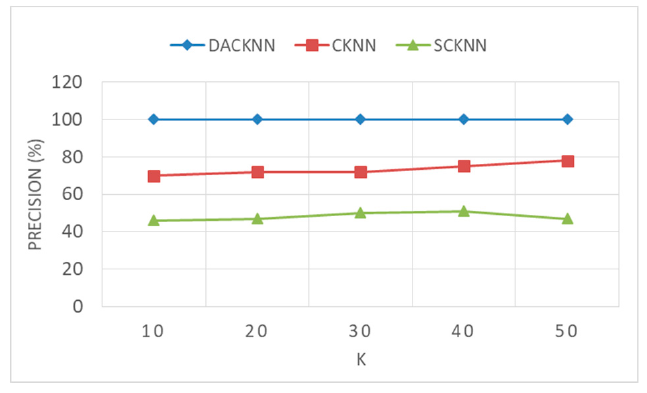
Figure 20. Accuracy of Algorithms for different K values.